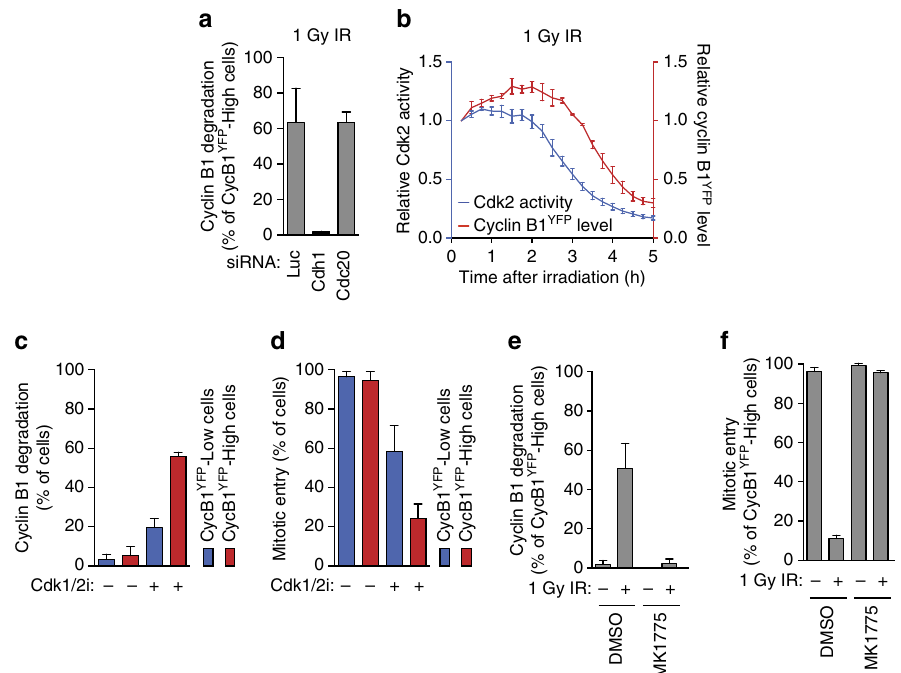
Figure 2 | DNA damage causes rapid APC/C Cdh1 activation in antephase. ( a ) Direct degradation of Cyclin B1 in antephase cells depleted for luciferase, Cdh1 or Cdc20 that were irradiated with 1Gy. Antephase cells were selected based on top 25% Cyclin B1 YFP -expressing cells, measured 15min after IR. Mean ± s.d. of two independent experiments. ( b ) Relative Cdk2 activity and Cyclin B1 YFP intensity were measured in individual antephase cells that degraded Cyclin B1 after 1Gy IR. All time points were normalized to Cdk2 activity and Cyclin B1 level at the first frame, which were set to one. Mean ± s.e.m. of three independent experiments. ( c , d ) Cyclin B1 degradation ( c ) and mitotic entry ( d ) scored in undamaged G2 and antephase cells within 10h after wash out of Cdk1 (RO-3306) and Cdk2 (Roscovitine) inhibitors that had been present for 5h. G2 and antephase cells were separated based on 75% lowest and 25% highest Cyclin B1 YFP -expressing cells. Mean ± s.e.m. of three independent experiments. ( e , f ) Cyclin B1 degradation ( e ) and mitotic entry ( f ) scored in antephase cells (selected as in Fig. 2a) within 10h after IR 1Gy. Wee1 inhibitor (MK 1775) or dimethylsulfoxide were added immediately after IR. Mean ± s.d. of three independent